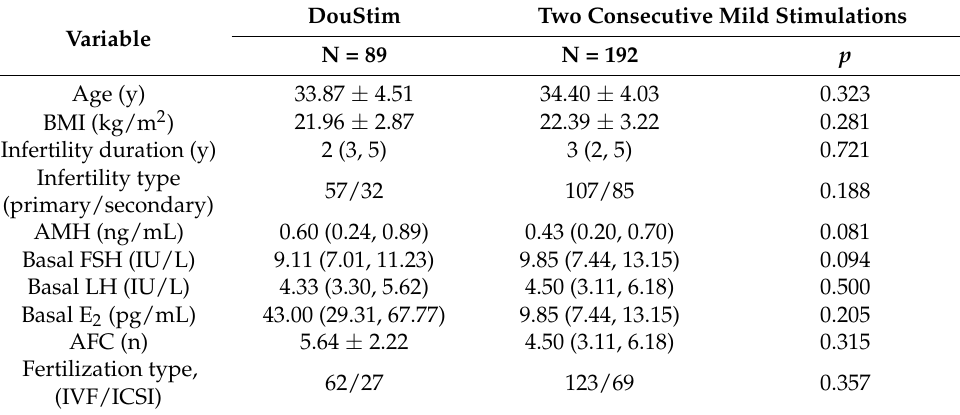
Table 1. Comparison of basic characteristics between the DouStim group and the two consecutive mild stimulations